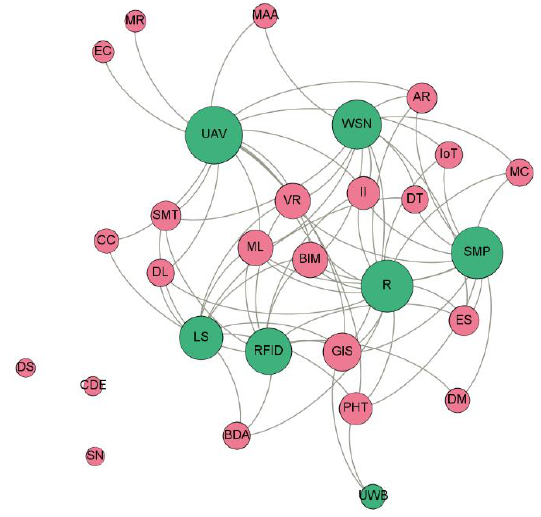
Figure 7. Interconnection network analysis—category.